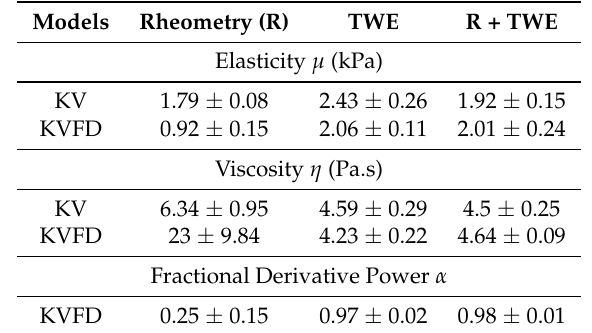
Table 7. Viscoelastic parameters of Ex vivo cervical tissue using data from rheometry (R), torsional wave elastography (TWE) and a combination of both techniques (R + TWE) for Kelvin–Voigt (KV) and Kelvin–Voigt fractional derivative (KVFD) models. Values are reported as means and standard